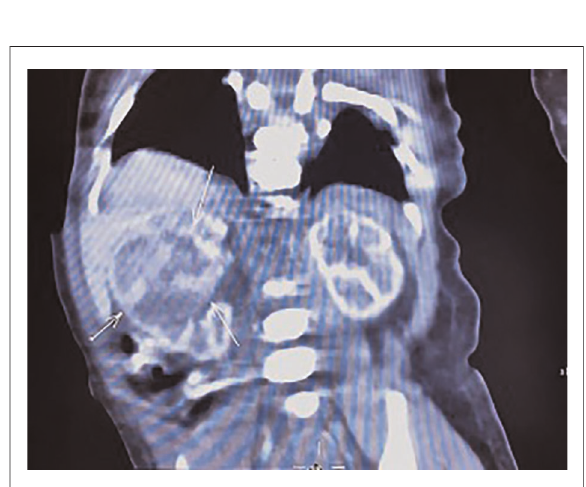
FIGURE 3 Enhance CT image of the newborn. A large, heterogeneous mass was noted in the middle of the right kidney with a size of 26 mm×26 mm×25 mm.